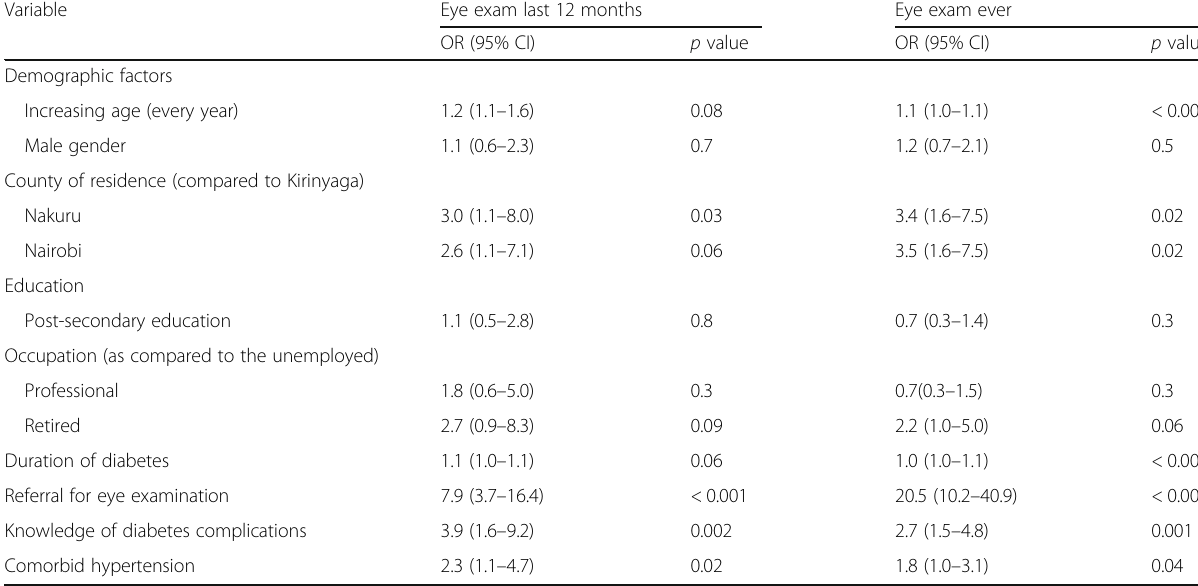
Table 3 Predictors of eye examination last 12